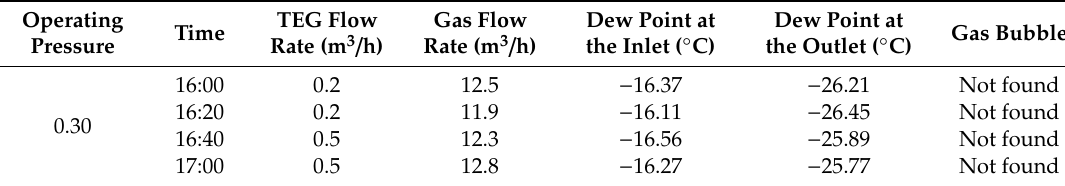
Table 10. Experimental results under dry gas source conditions.